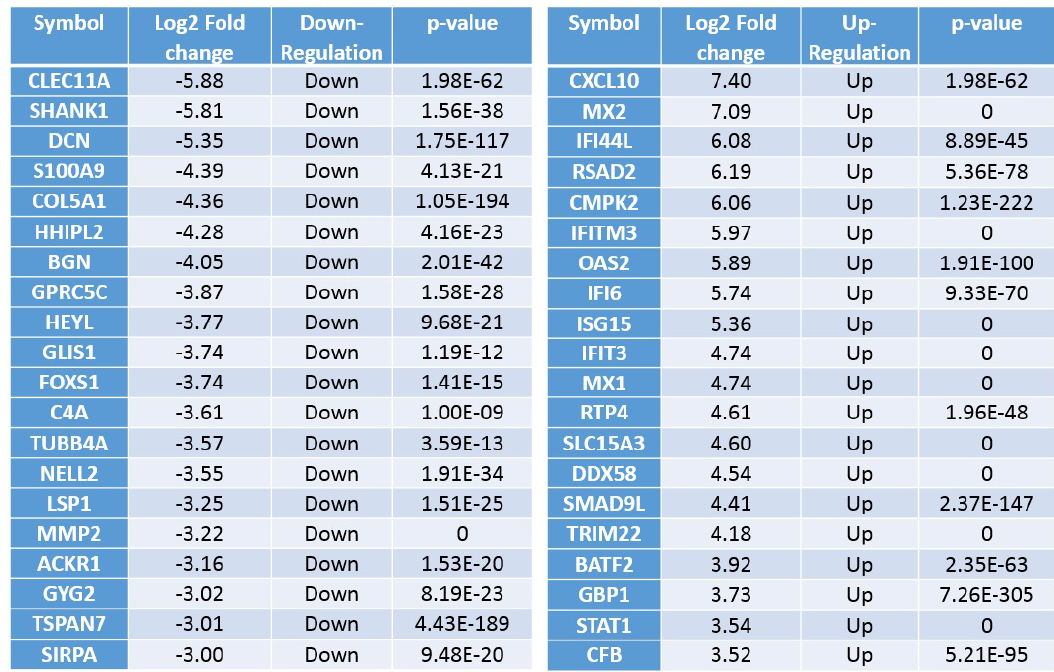
Figure 3. Differentially expressed genes. Top upregulated and downregulated genes when silencing RGS4 in GSC20 cells.